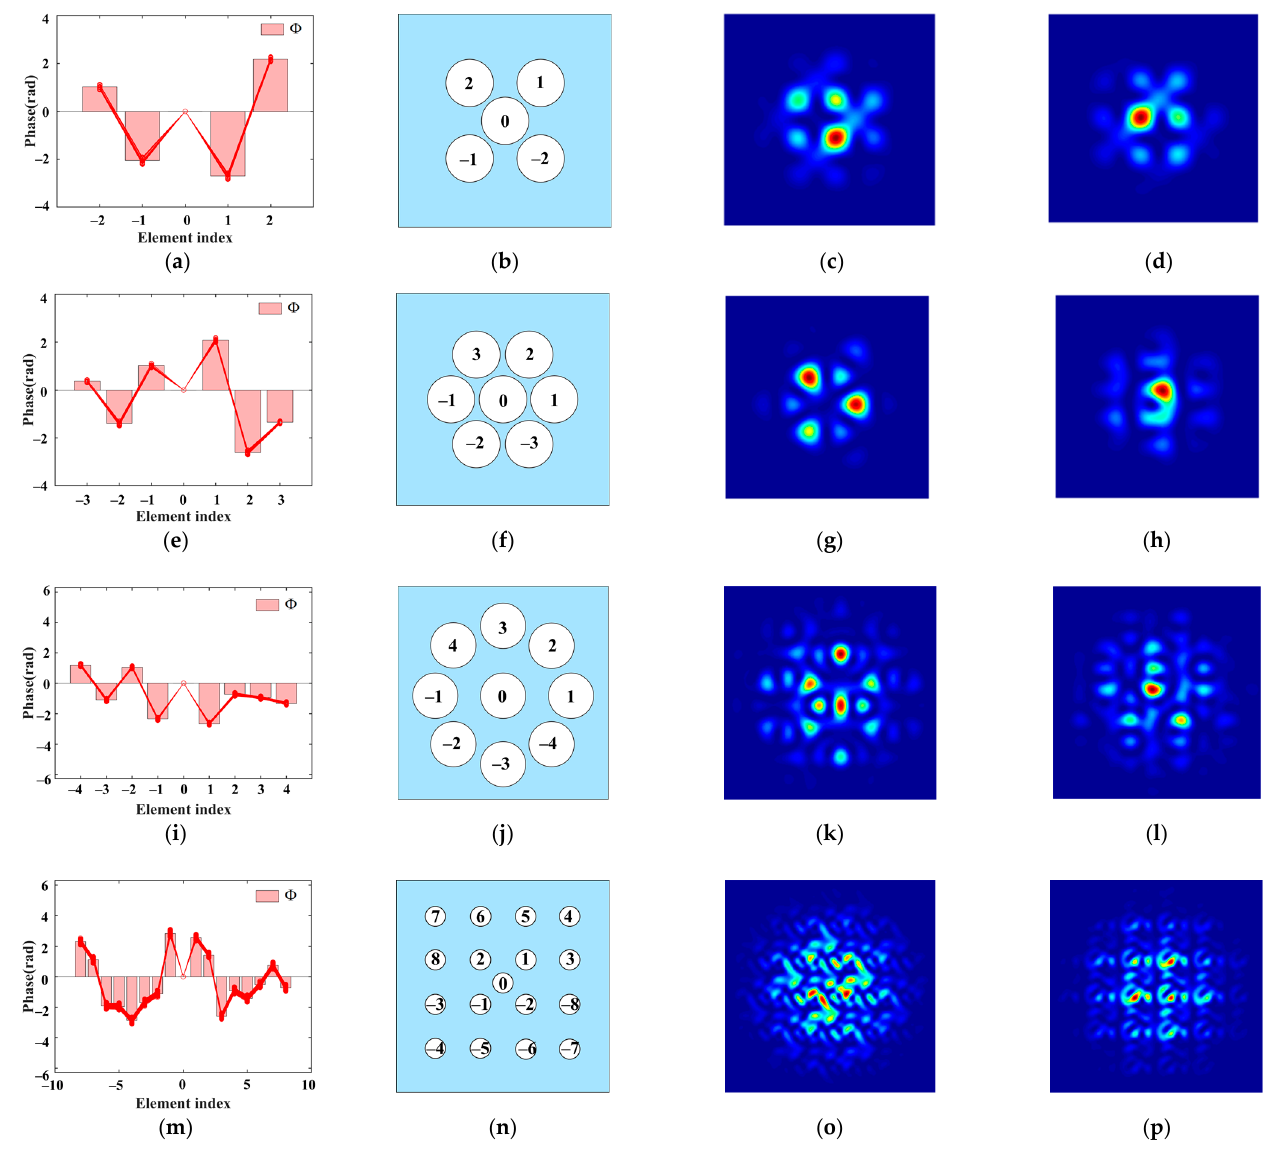
Figure 8. ( a ) Solutions which generate the samiliar far field as Φ with and without modulated in 5-element; ( b ) Emissive plane and element index in 5-element; ( c ) Modulated far-field generated by Φ in the 5-element system; ( d ) Modulated far-field generated by Φ in the 5-element system; ( e ) Solutions which generate the samiliar far field as Φ with and without modulated in the 7-element system; ( f ) Emissive plane and element index in the 7-element system; ( g ) Modulated far-field generated by Φ in the 7-element system; ( h ) Modulated far-field generated by Φ in the 7-element system; ( i ) Solutions which generate the samiliar far field as Φ with and without modulated in the 9-element system; ( j ) Emissive plane and element index in the 9-element sstem; ( k ) Modulated far-field generated by Φ in the 9-element system; ( l ) Modulated far-field generated by Φ in the 9-element system; ( m ) Solutions which generate the samiliar far field as Φ with and without modulated in the 17-element system; ( n ) Emissive plane and element index in the 17-element system; ( o ) Modulated far-field generated by Φ in the 17-element system; ( p ) Modulated far-field generated by Φ in the 17-element system.